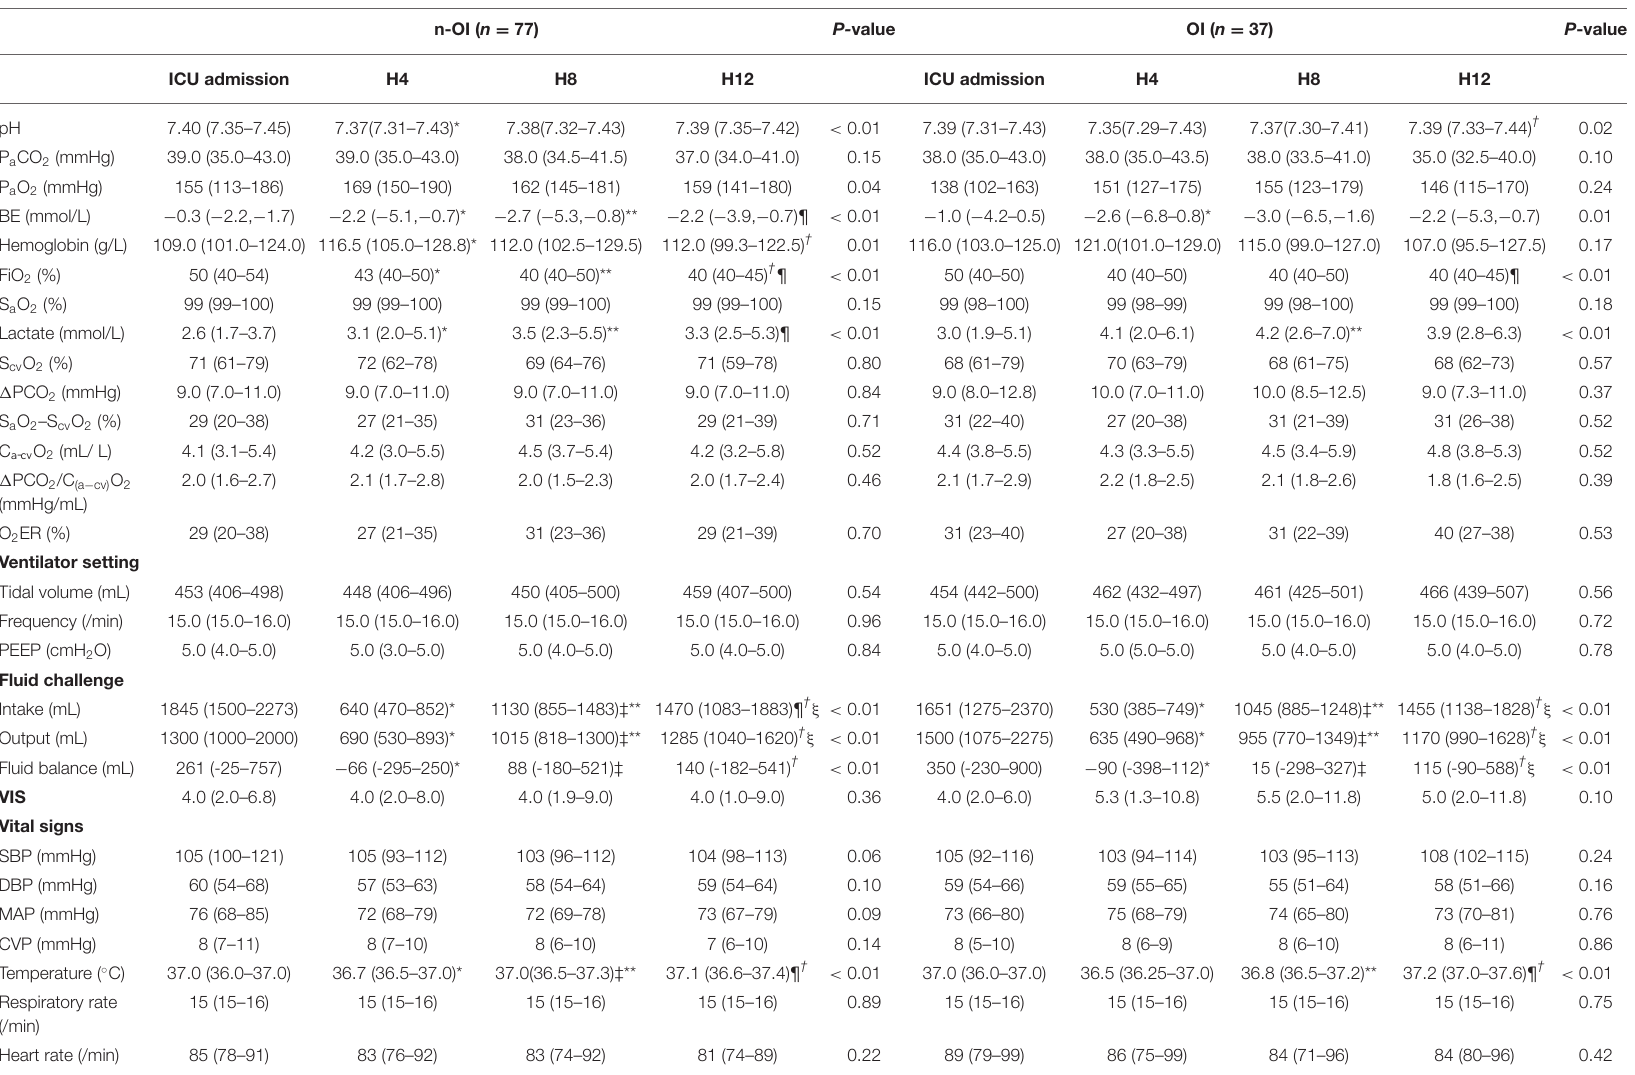
TABLE 2 | Clinical data on ICU admission and at H4, H8, H12 post admission in n-OI and OI